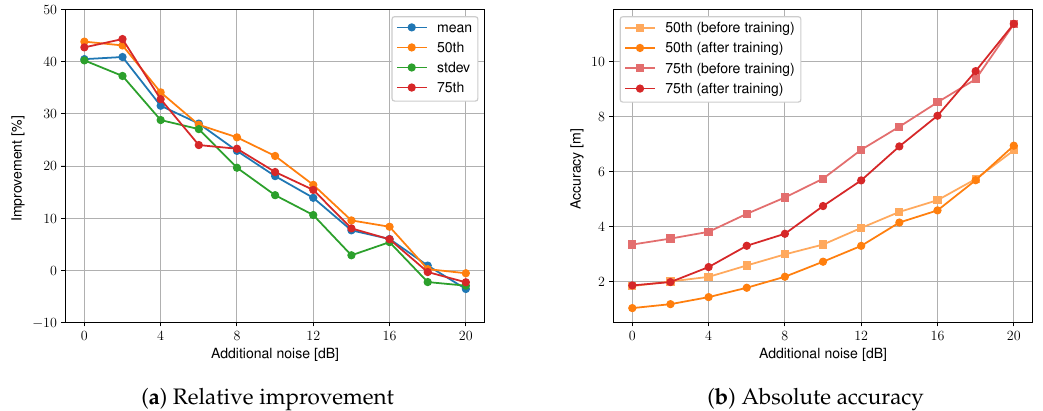
Figure 6. Accuracy before and after unsupervised learning for a varying level of additional noise with the normal access point configuration.